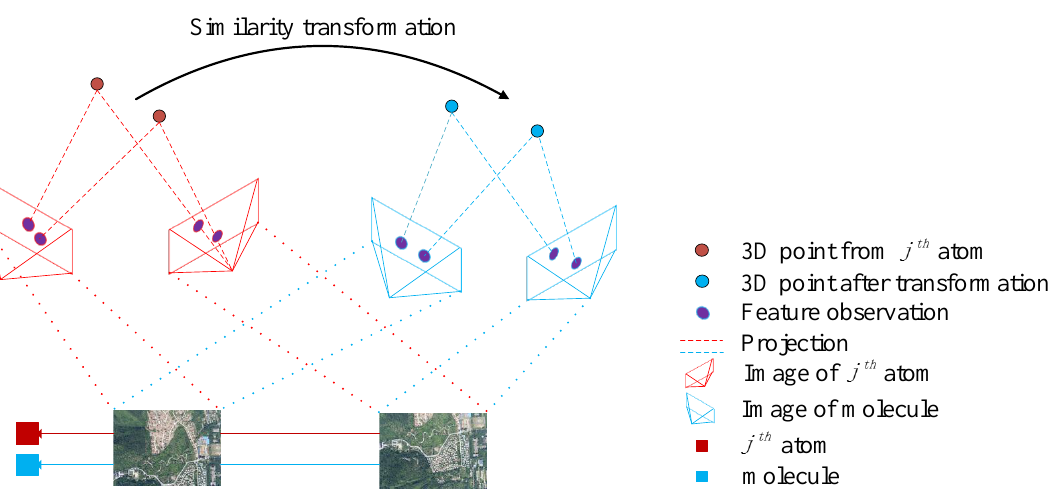
T 2 T 3 . A closed-loop constraint is formed by a similarity j j j